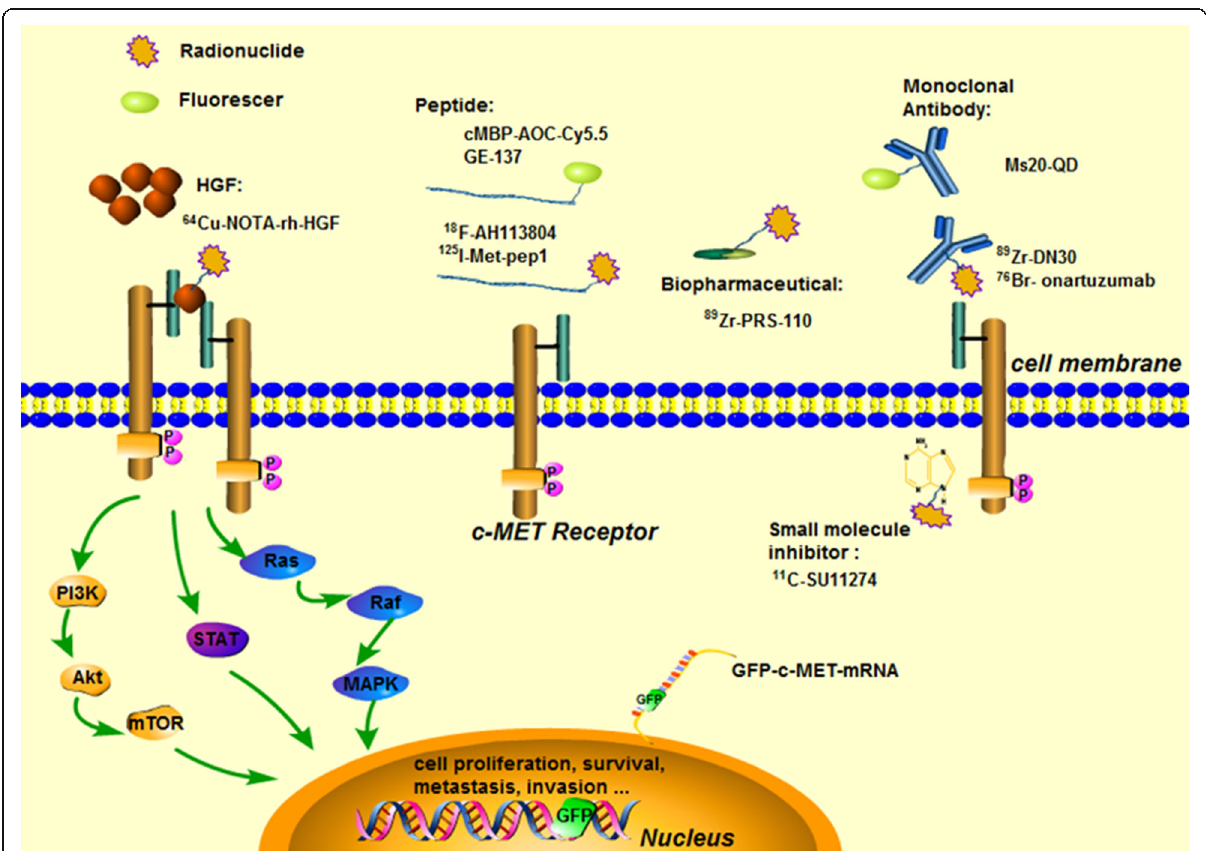
Fig. 1 A visual overview of the c-MET/HGF signaling pathway with different biological effects and also of representative imaging agents targeting to either extracellular or intracellular domains of c-MET